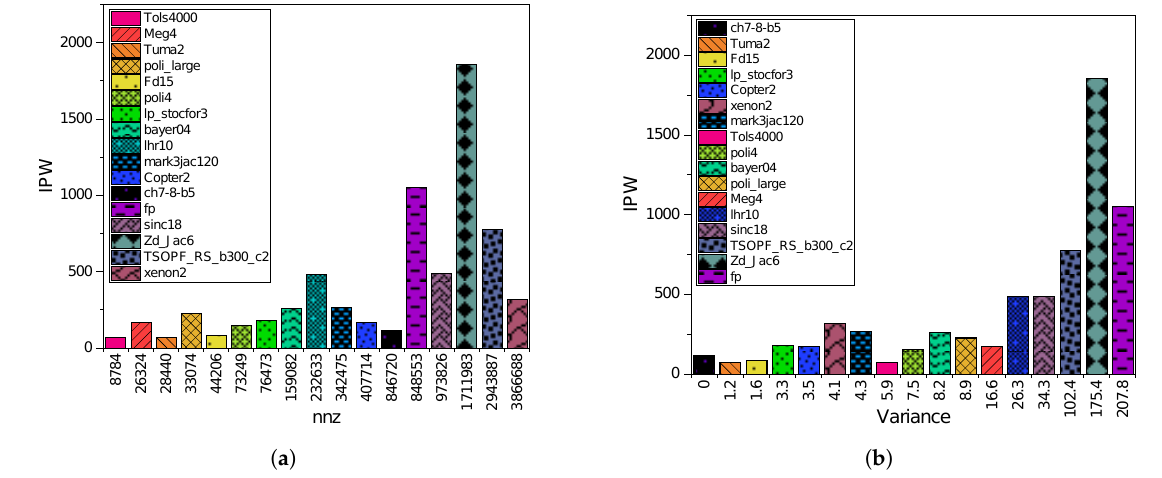
Figure 4. CSR instructions per warp (IPW) against: ( a ) nnz and ( b ) npr variance .